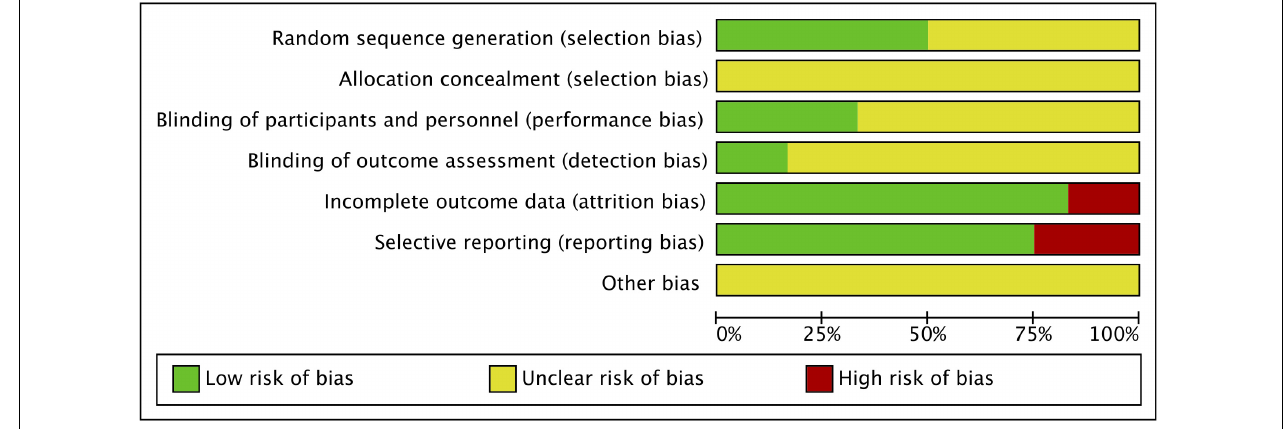
FIGURE 2 | Risk of bias graph.